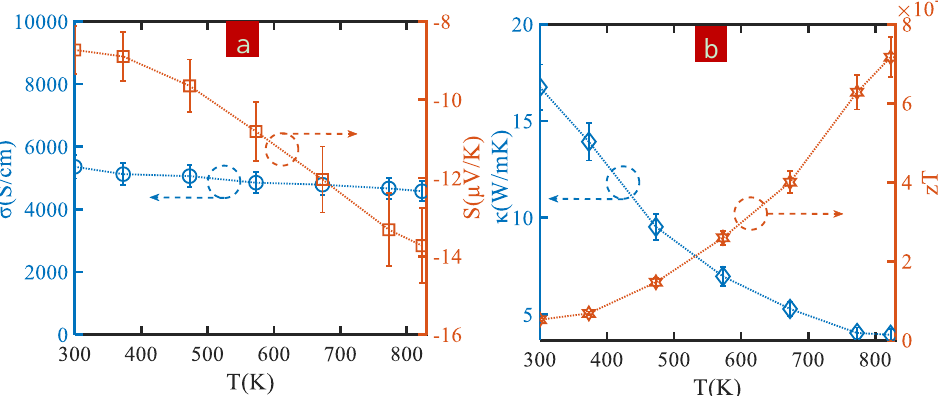
Figure 5. Temperature dependence thermoelectric parameters of CoVSn compounds. ( a ) electrical conductivity and Seebeck coefficient, ( b ) Thermal conductivity and zT.